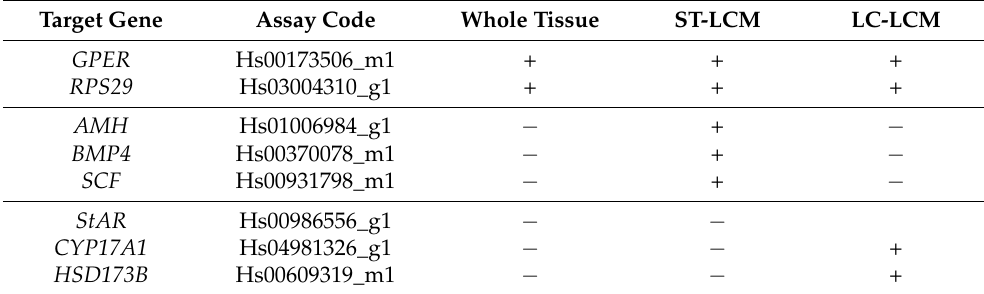
Table 2. TaqMan ® Gene Expression Assays used in the study. Target